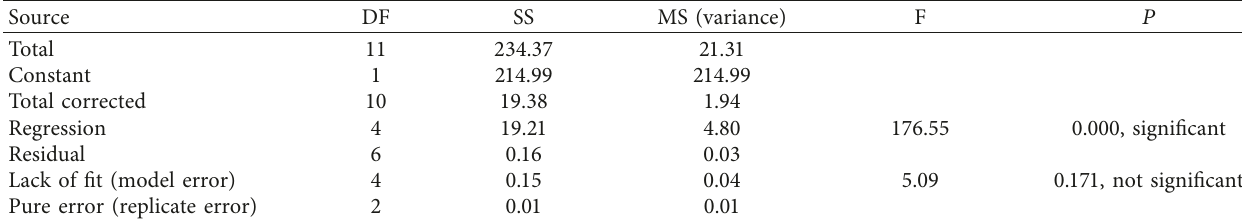
Table 3: Analysis of variance (ANOVA) for the response surface quadratic model.